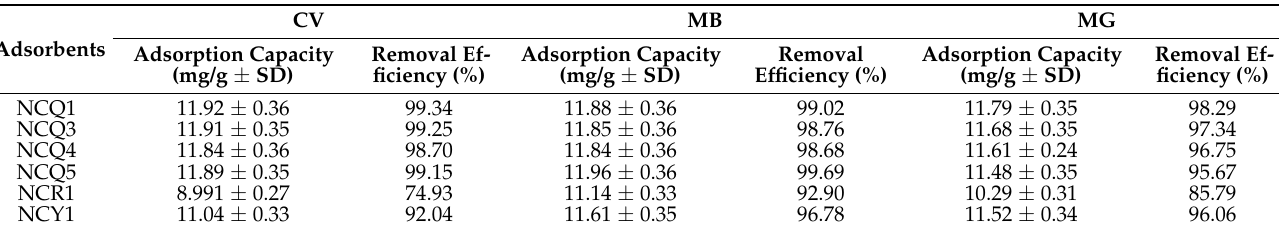
Table 1. Adsorption selectivity experiments with dye